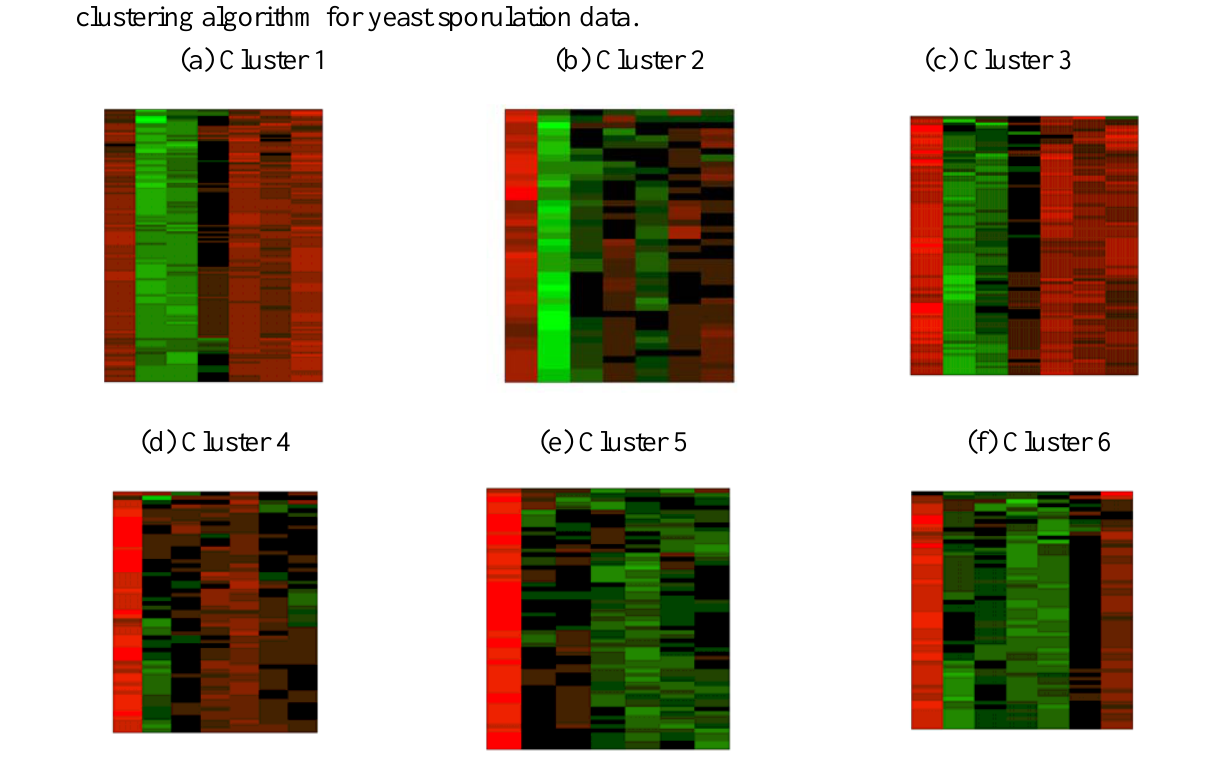
Figure 11. Heatmaps (Eisen plots) for clustering solution obtained by MODE-based clustering algorithm for yeast sporulation